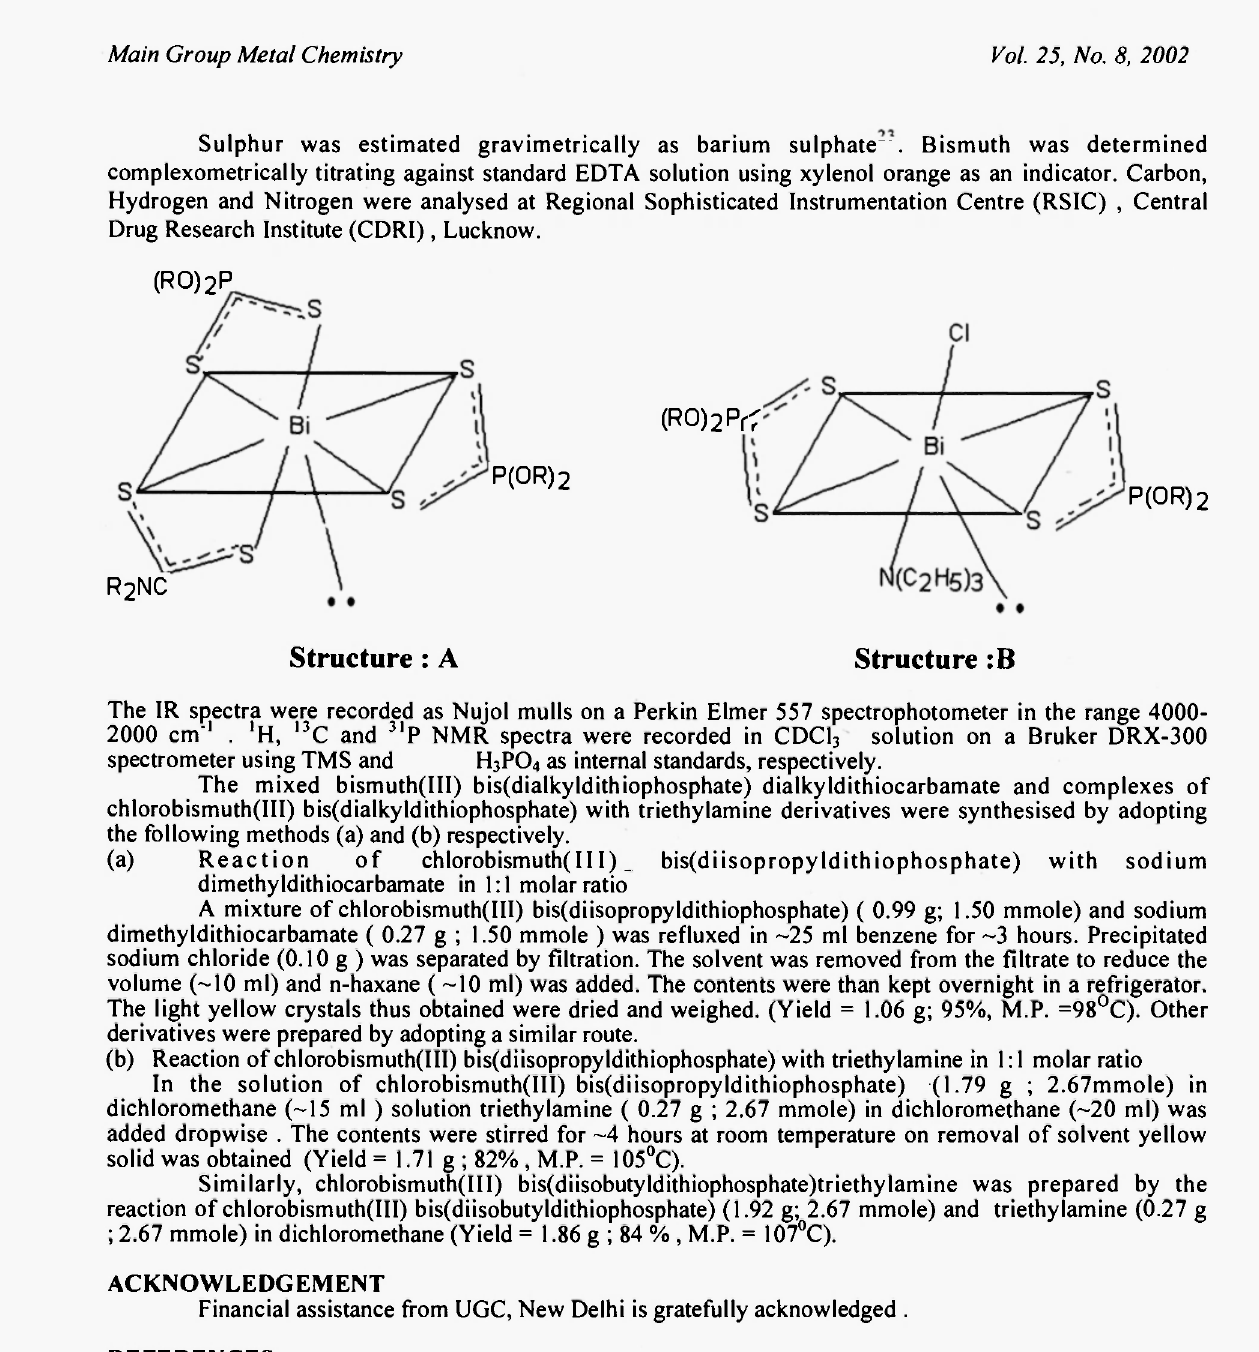
Sulphur was estimated gravimetrically as barium sulphate . Bismuth was determined complexometrically titrating against standard EDTA solution using xylenol orange as an indicator. Carbon, Hydrogen and Nitrogen were analysed at Regional Sophisticated Instrumentation Centre (RSIC) , Central Drug Research Institute (CDRI), Lucknow.